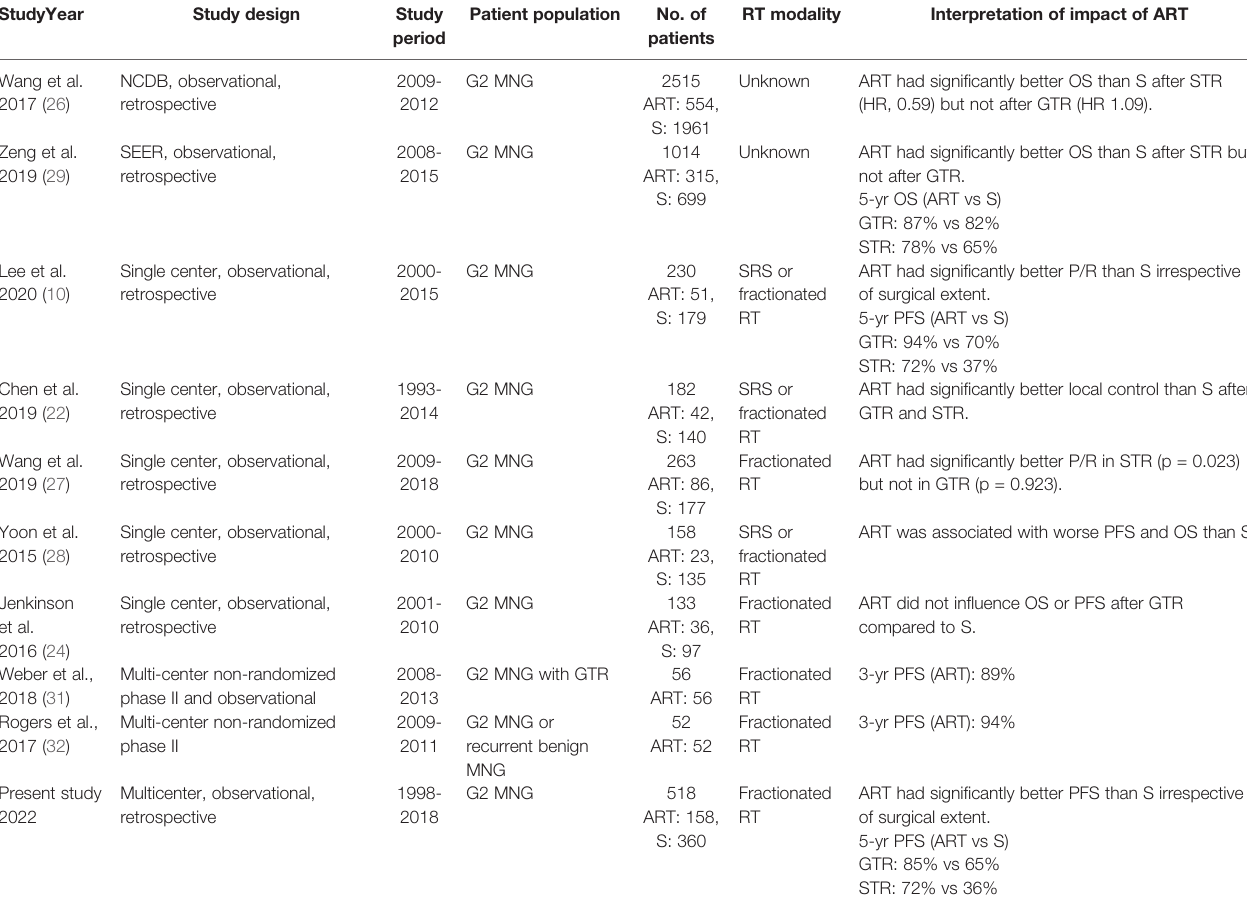
TABLE 3 | Summary of retrospective studies comparing adjuvant radiotherapy and surveillance after surgery for grade 2 meningiomas and prospective single arm studies showing the results of adjuvant